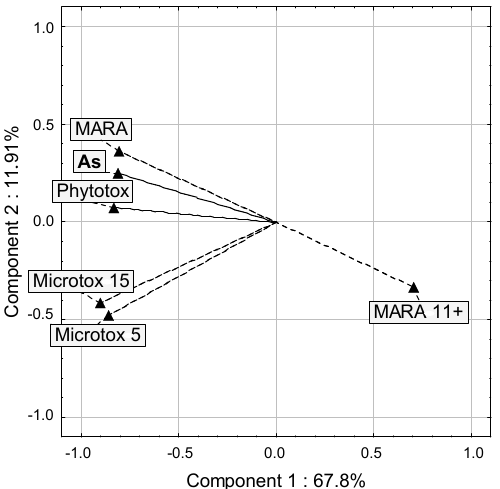
Figure 4. The results of principal component analysis (PCA) performed for soils 1 and 2.